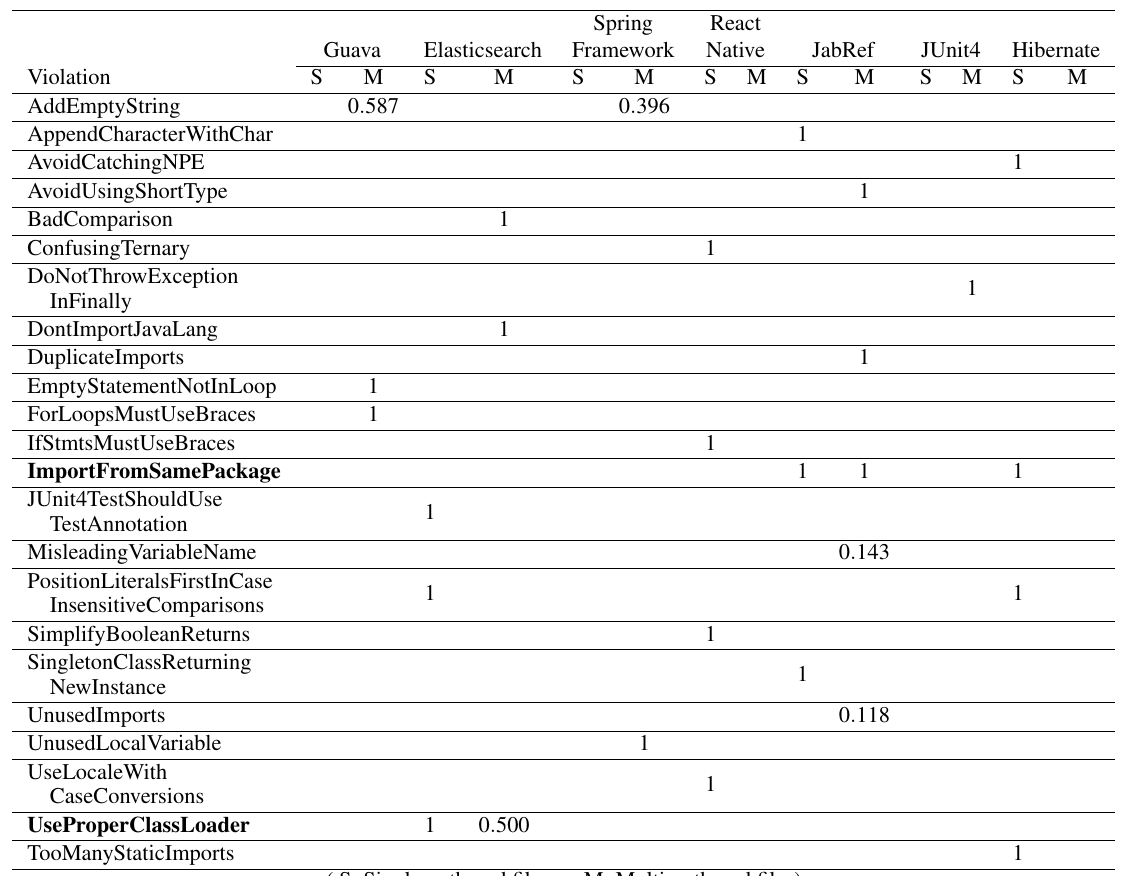
Table 5. Appearing violations whose NIPA values are greater than zero in single-authored files or multi-authored files.